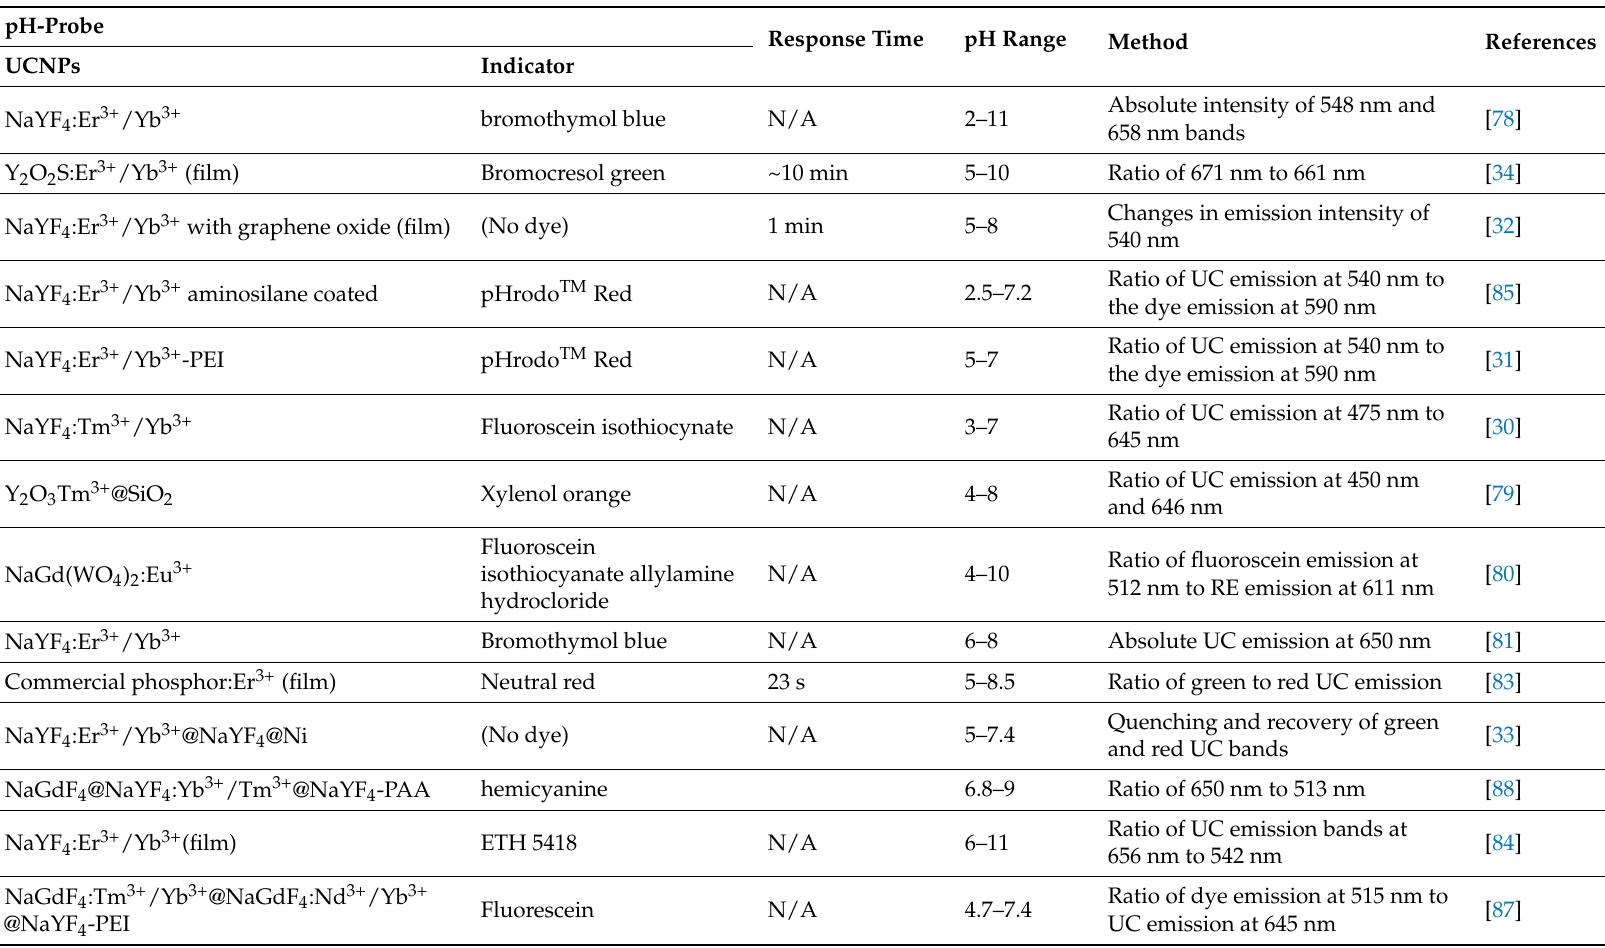
Table 2. Upconversion based pH-sensors with their response time, range and